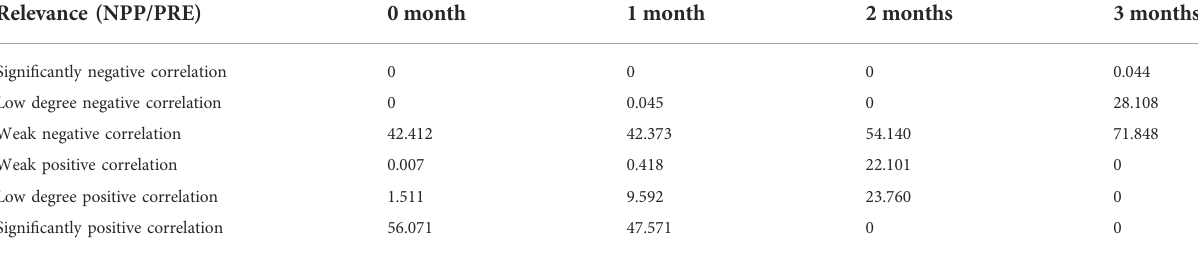
TABLE 3 Proportion of watershed area with different correlation degree between NPP and precipitation under different lag time (%). Relevance (NPP/PRE) 0 month 1 month 2 months 3 months Signi fi cantly negative correlation 0 0 0 0.044 Low degree negative correlation 0 0.045 Weak negative correlation Weak positive correlation 0.007 Low degree positive correlation Signi fi cantly positive